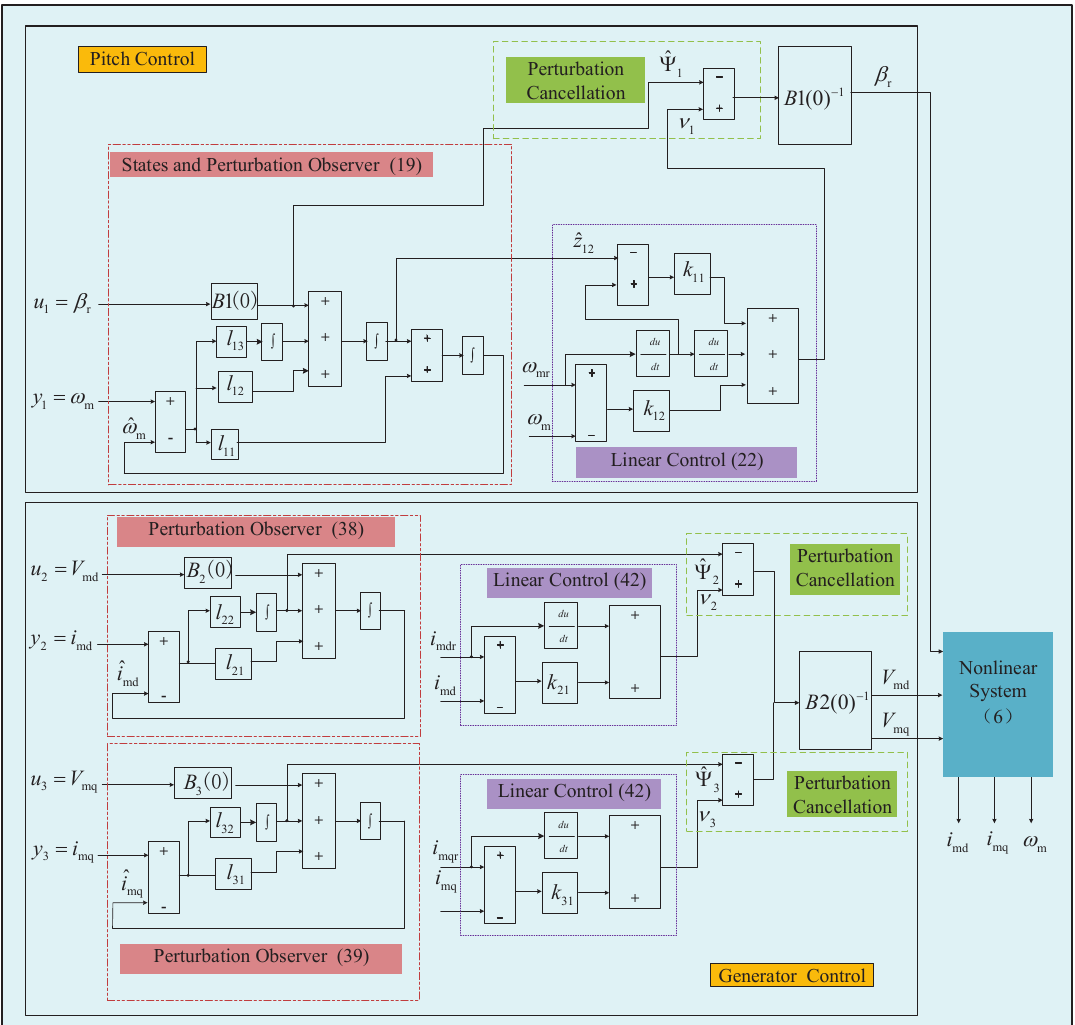
Figure 4. Block diagram of nonlinear adaptive